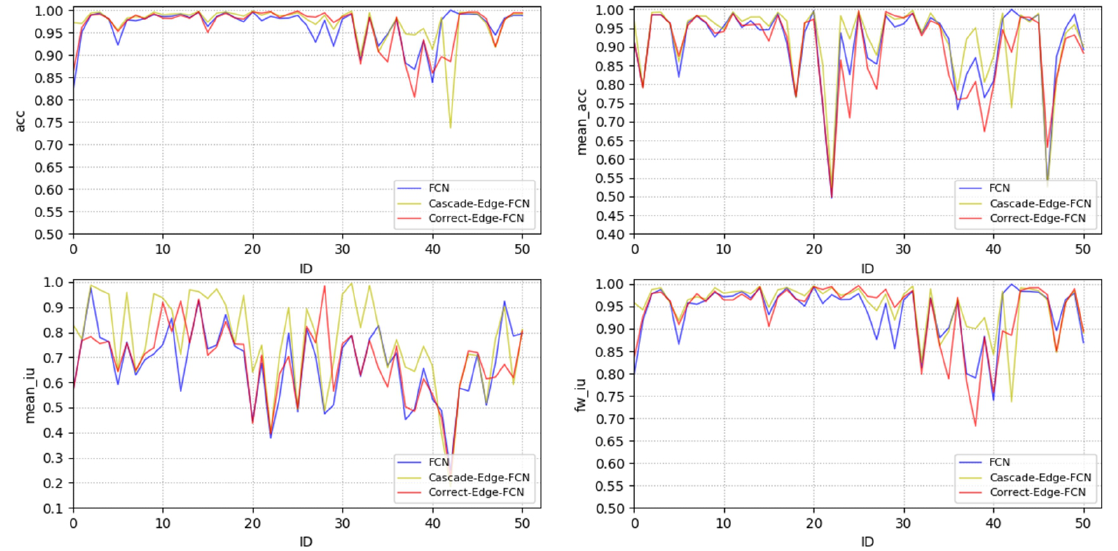
Figure 12. Evaluation results of each image in test set of GID. Here, we abandon the images with acc < 0.7.